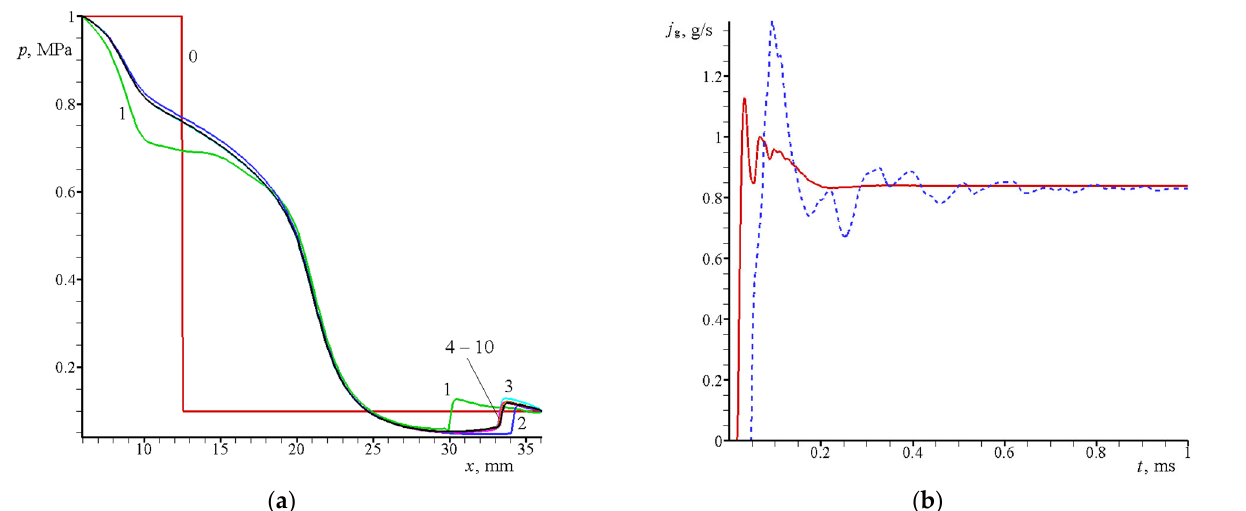
Figure 4. Calculation results for the unsteady gas flow exhausting into the slot space of height h = 0.2 mm: ( a )—dependence of gas pressure on the axis y = 0 at ten times t i following at time intervals ∆ t = 0.1 ms; ( b )—dependence of gas-flow rate on time in the inlet and outlet sections of the channel (solid red line and blue dashed line, respectively).